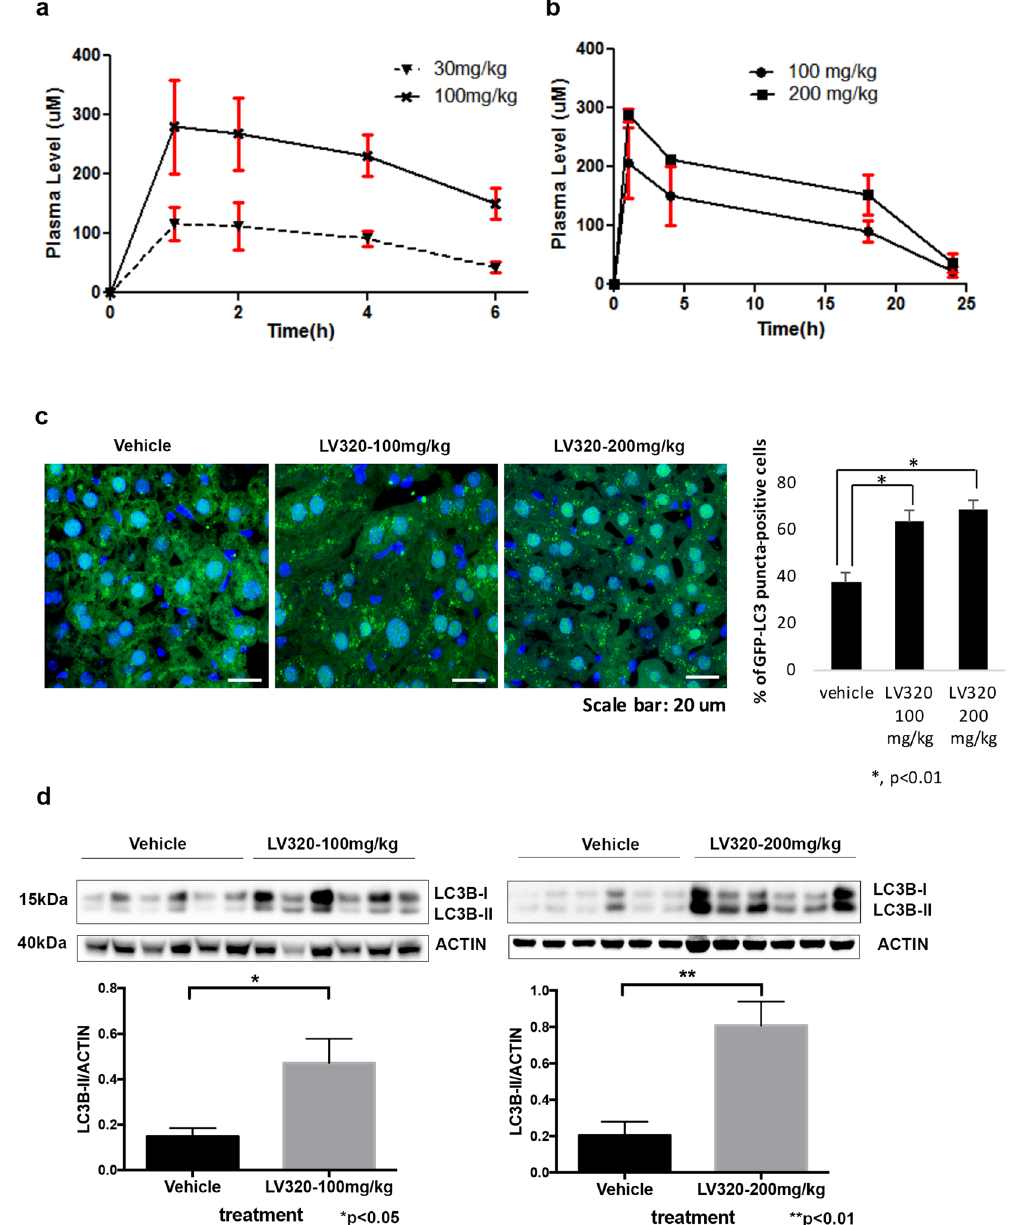
Figure 7. LV-320 is bioavailable and affects LC3B levels in vivo . ( a ) Plasma levels of LV-320 in BL/6 mice (n = 3, serial samples) after oral doses of 30 or 100 mg/kg; error bars, SD ( b ) Plasma levels of LV-320 in BL/6 mice (n = 3, serial samples) after oral doses of 100 or 200 mg/kg; error bars, SD ( c ) LV-320 treatment results in accumulation of GFP-LC3 puncta in mouse liver tissues. Representative images from each treatment condition are shown in the left panel. Scale bar, 20 µ m. Quantitative data are shown in the right panel. The percentage of GFP-LC3 puncta positive cells from 5 fields were calculated for each sample; and 6 samples from each treatment condition were grouped; * P < 0.01 (Student’s two-tailed t -test). ( d ) LV-320 treatment results in accumulation of LC3B-II in a dose-dependent manner. Corresponding mean LC3B-II/actin values (per treatment group) were determined using densitometry analysis; error bars, SEM. * p < 0.05, ** p < 0.01, Student’s t-test. Full-length blots are presented in Fig.